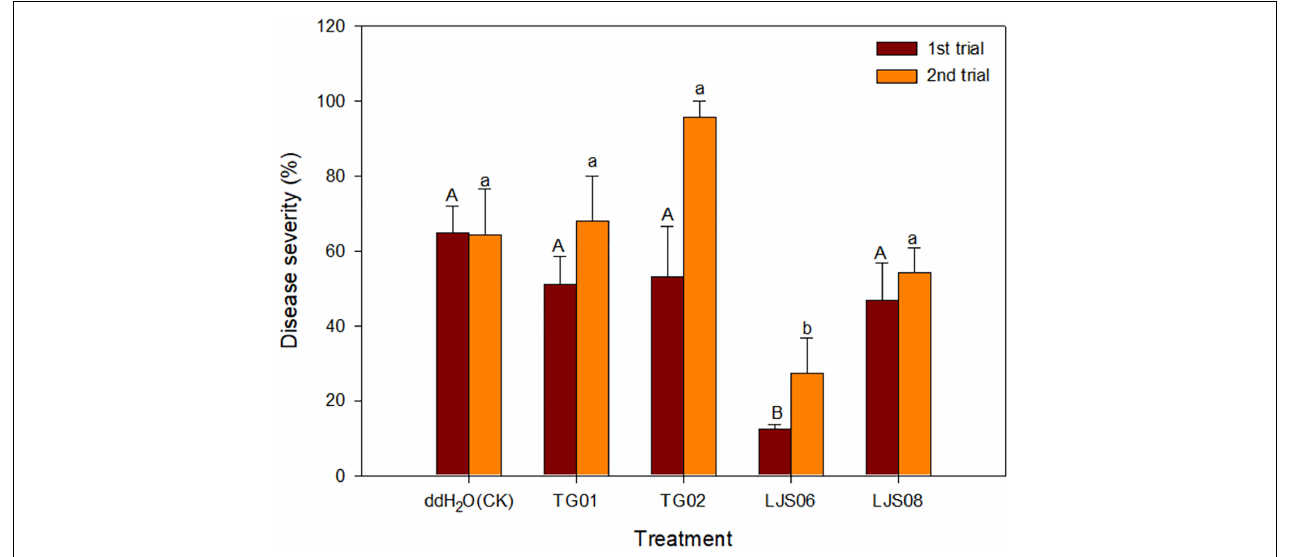
FIGURE 1 | Effect of spore suspension of four antagonistic bacterial strains on disease severity of cucumber anthracnose caused by Colletotrichum orbiculare COC3. Means ( n = 4) in the same trial indicated by different letters significantly differ ( p < 0.05) according to Fisher’s least significant difference test. Bar = standard error.